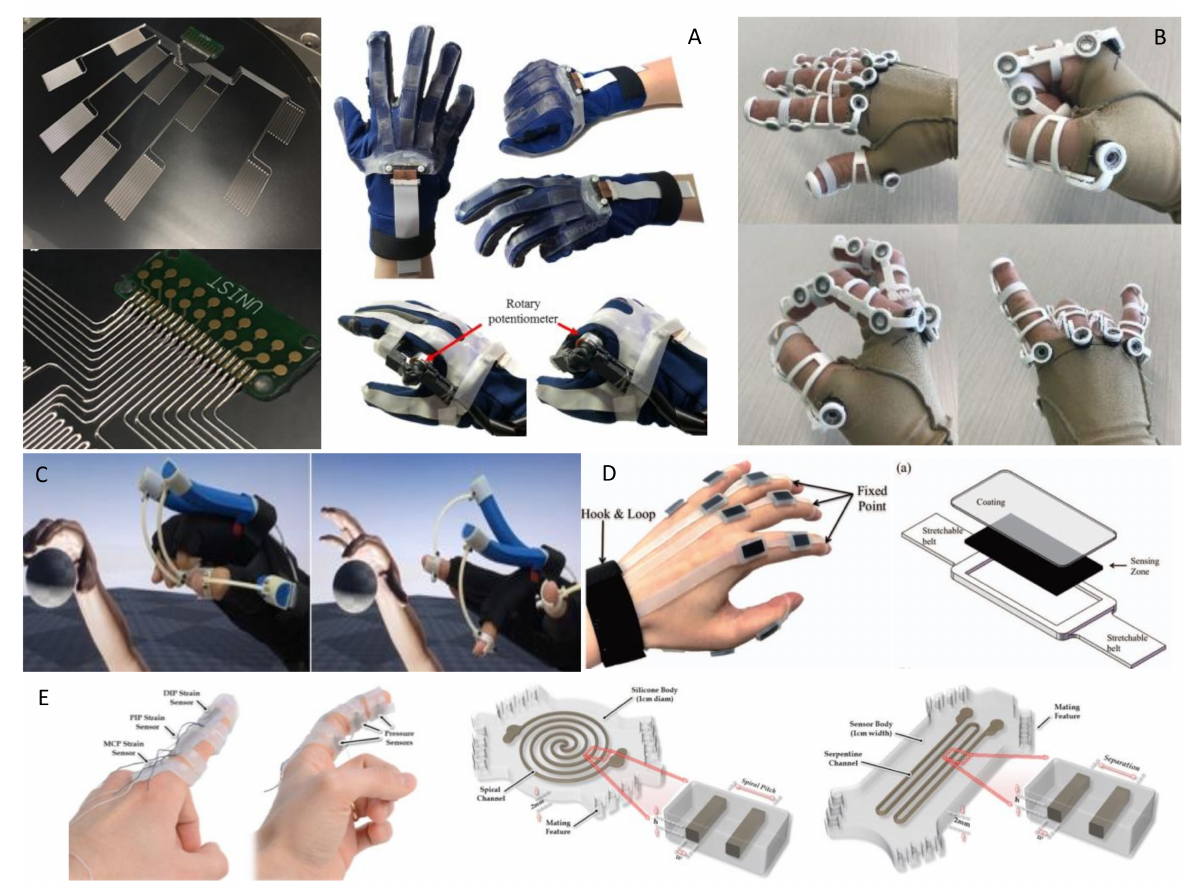
Figure 26. Haptic soft gloves. ( A ) Soft sensors produced with direct ink writing (DIW) of a conductive liquid ([76]). Reprinted/adapted with permission from Ref. [76]. 2018, IEEE. ( B ) Hybrid exoskeletal- soft glove for the application of sensors that can be placed close to the center of rotation of the digit joints ([79]). Reprinted/adapted with permission from Ref. [79]. 2019, IEEE. ( C ) Haptic force feedback soft glove actuated by fiber-reinforced pneumatic soft bending actuators [78]. Reprinted/adapted with permission from Ref. [78]. 2020, IEEE. ( D ) Novel low-cost soft stretchable bending sensor, with bending/stretching feature [80]. Letter (a) refers to the original source. ( E ) Pressure and strain sensors, based on conductive fluid resistance variation, embedded in a silicone made structure [81]. Reprinted/adapted with permission from Ref. [81]. 2014, IEEE.